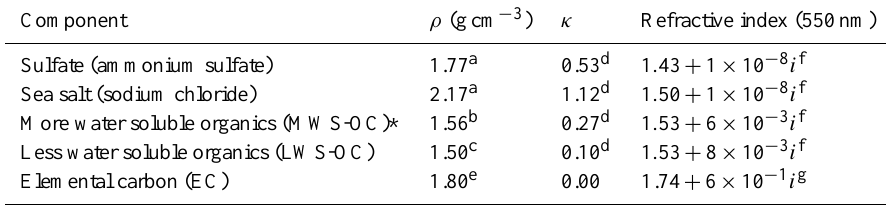
Table 3. Density ( ρ) , hygroscopicity parameter ( κ) and refractive index (at 550nm) for considered chemical